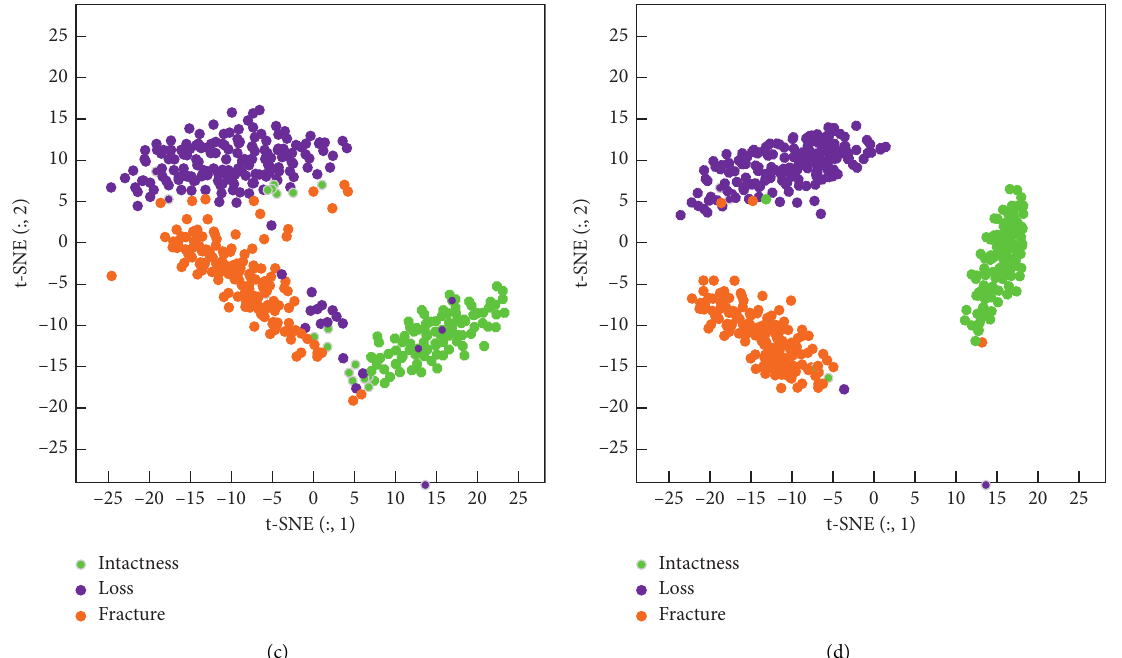
Figure 15: Test data distributions for different modes. (a) LBP +SVM, (b) HOG +SVM, (c) VGG16, and (d) GAN +ResNet.